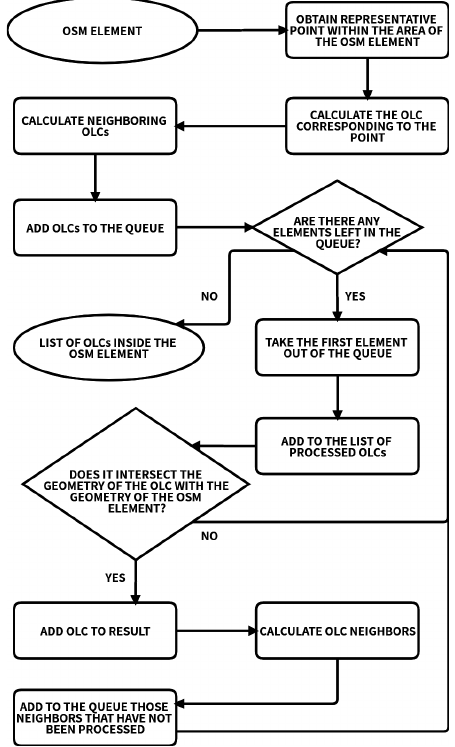
Figure 5. Process for calculating the OLC cells that intersect with a way